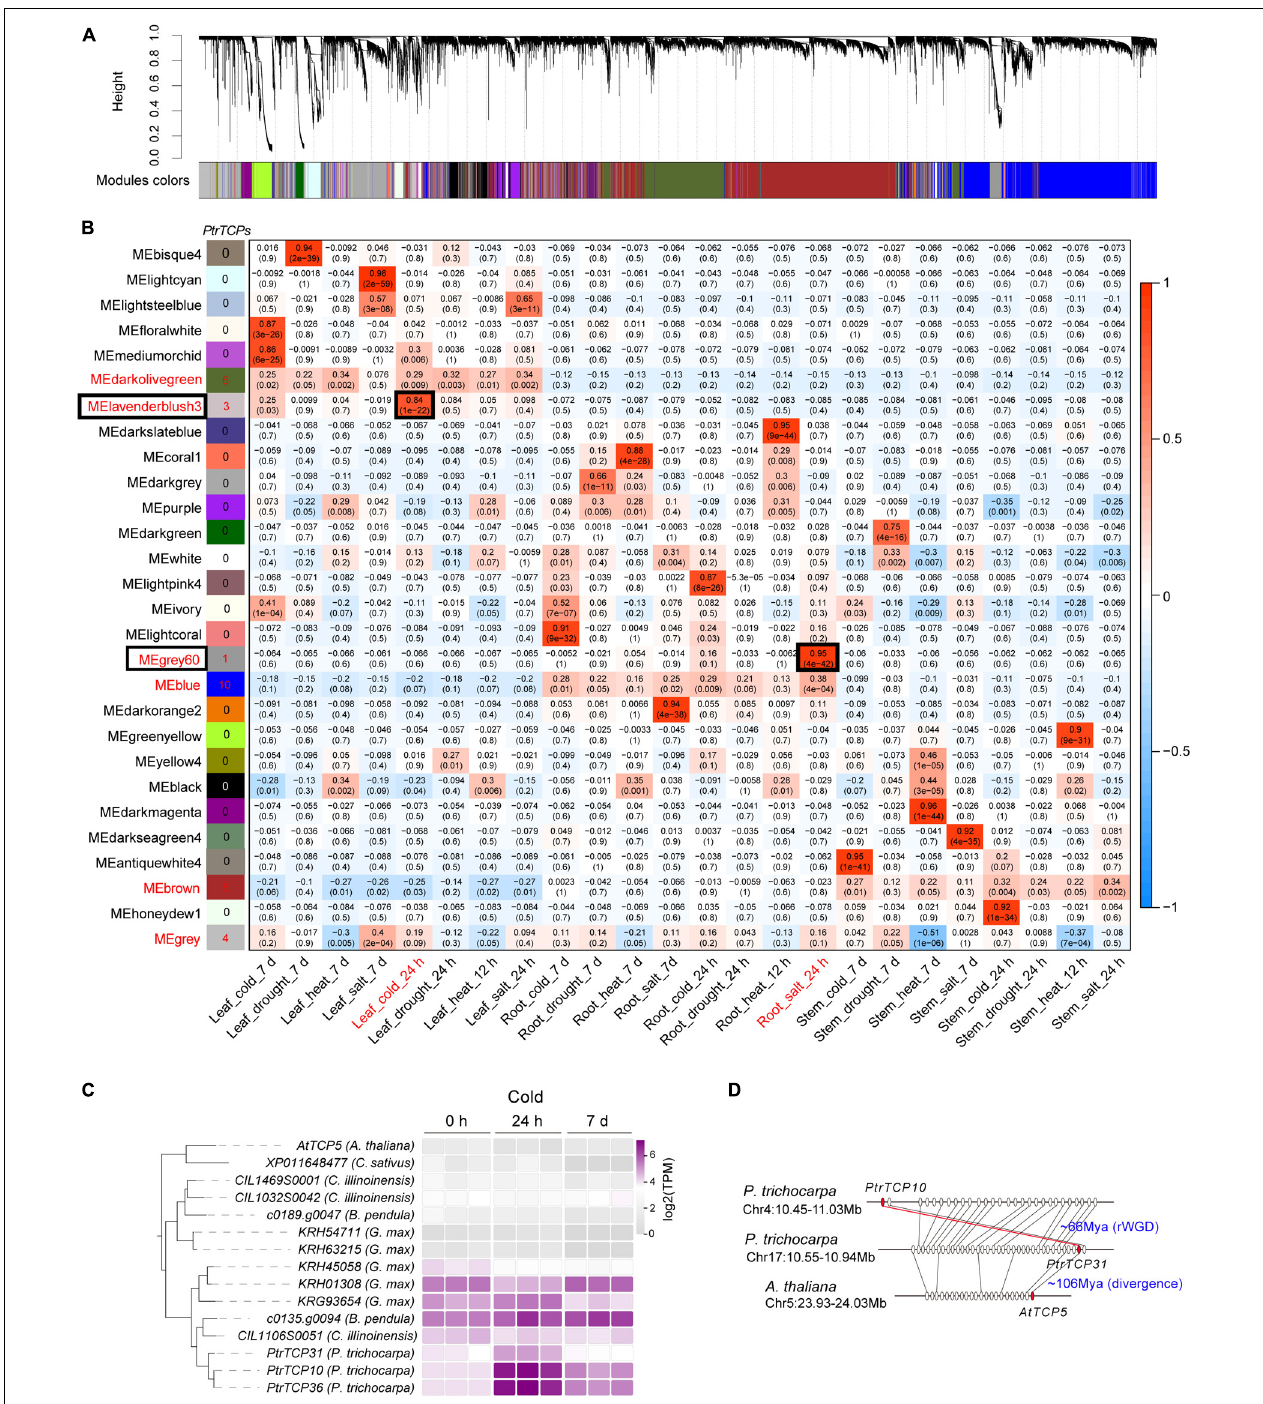
FIGURE 7 | Distribution of PtrTCP genes in the regulatory modules of P. trichocarpa tissues under abiotic stresses. (A) Gene regulatory modules identified by weighted gene co-expression network analysis (WGCNA). (B) Relationships of module eigengenes (ME, rows) and traits of the tissues under abiotic stresses (columns). Red/blue represents positive/negative correlations between the modules and the traits. The six modules containing PtrTCP genes were marked in red, and the number of PtrTCP genes was shown nearby. Of the six modules, the ones significantly correlated with one of the traits were especially shown in the box, and the corresponding traits were colored in red. (C) Expression conservation and divergence of PtrTCP31/10/36 orthologs in dicots under cold stress at different time points (0 h, 24 h, and 7 days). The cold-treated samples were from Arabidopsis thaliana (A. thaliana), Cucumis sativus (C. sativus), Carya illinoinensis (C. illinoinensis), Betula pendula (B. pendula), Glycine max (G. max) , and Populus trichocarpa (P. trichocarpa) . (D) The generation process of PtrTCP10 gene. PtrTCP10 was rWGD-duplicated from PtrTCP31 and underwent an inversion, where the P. trichocarpa region containing PtrTCP31 (Chr17:10.55–10.94) showed collinear orthologous gene pairs with Arabidopsis homologous region (Chr5:23.93–24.03 Mb) containing AtTCP5.